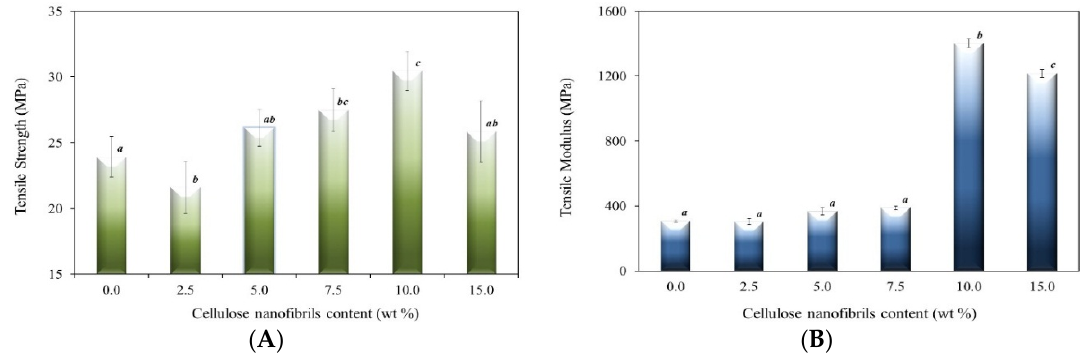
Figure 1. ( A ) Tensile strength and ( B ) Tensile modulus of cellulose nanofibril (CNF)-reinforced alginate films as the function of the CNF content (lower case letters (a, b, c) show Duncan grouping; distinct letters represent means significantly different ( p < 0.05)).